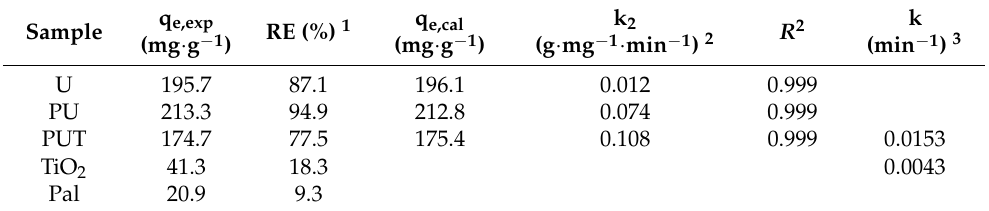
Table 1. Experimentally obtained and calculated values for q e , removal efficiency (RE %), and correlation coefficient ( R 2 ) for the pseudo-second-order kinetic model used to simulate the adsorption process and photocatalytic rate constant